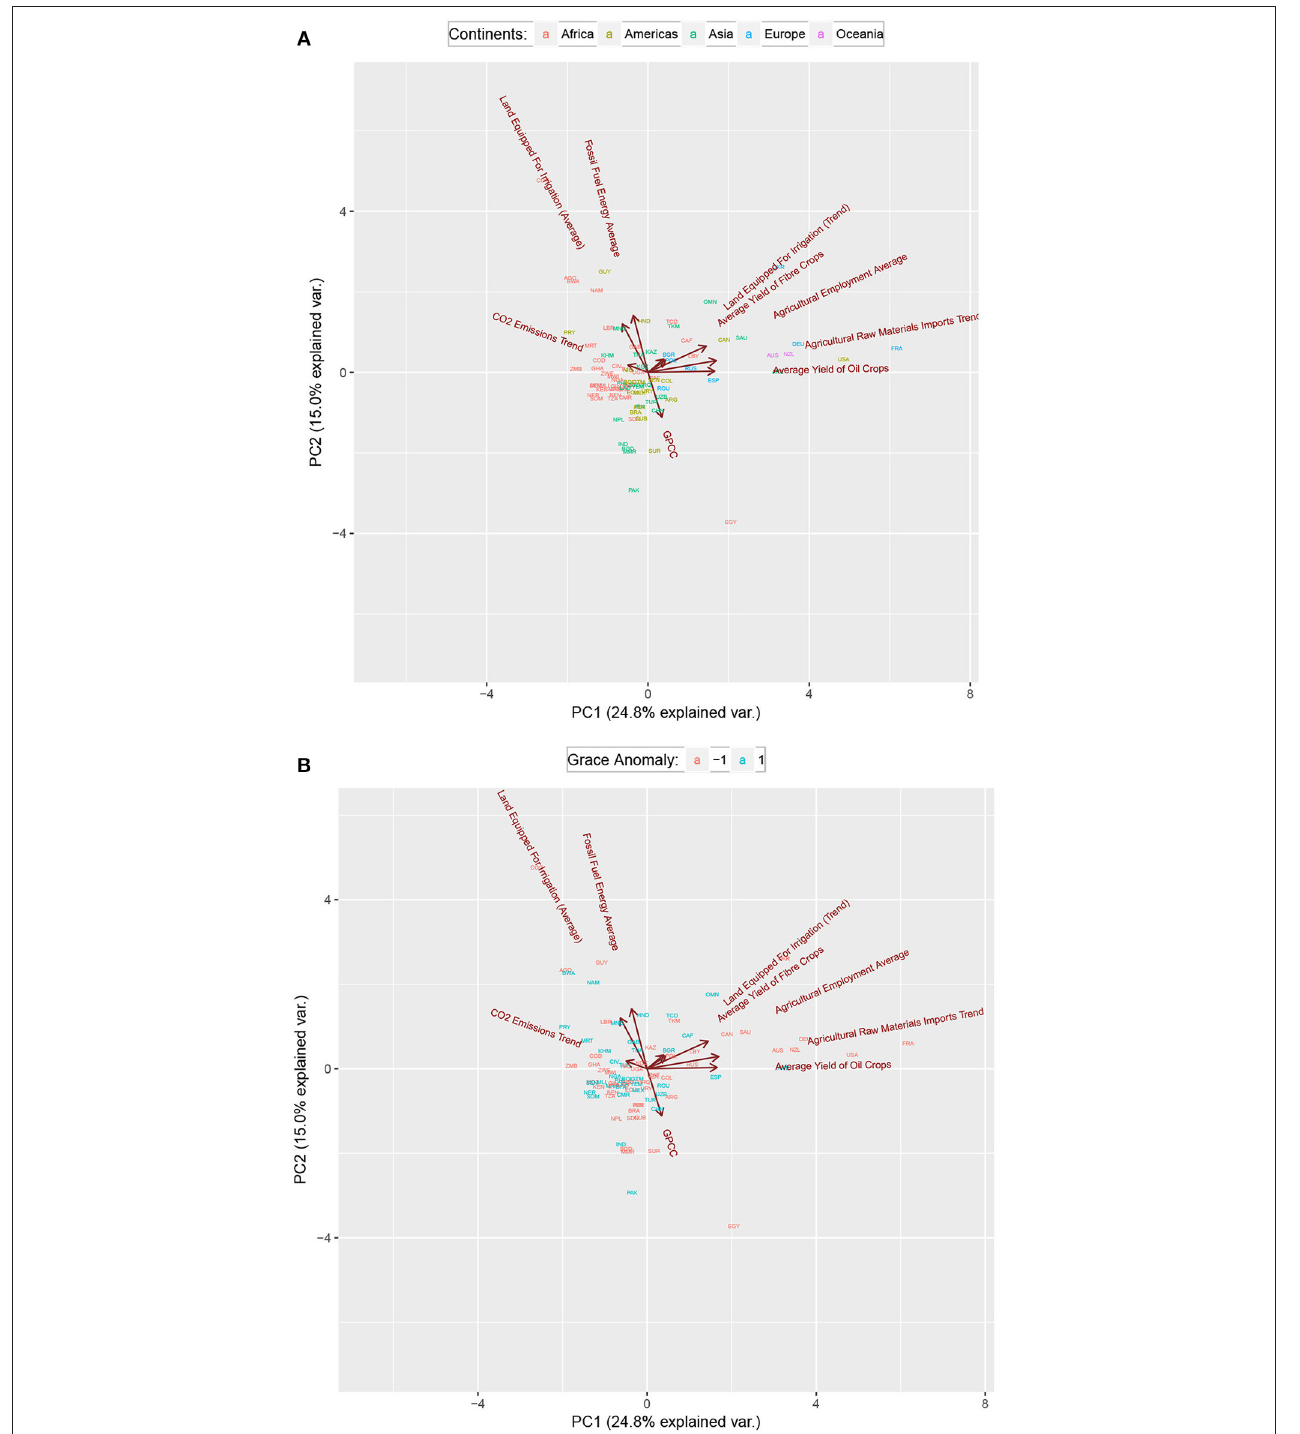
FIGURE 2 | (A) PCA-Biplot of input data, the countries are color-coded by continents, (B) PCA Biplots of input data, with color red indicating negative and blue indicating positive GRACE anomalies. ˆ The goal of supervised learning is to use the training data to interest L = R ω ( X ) 1 [ f ( x ), f ( X )] dX is minimized over the ˆ entire domain of input data; where ω ( X ) stands for a approximate the function f ( X ) such that the loss function of